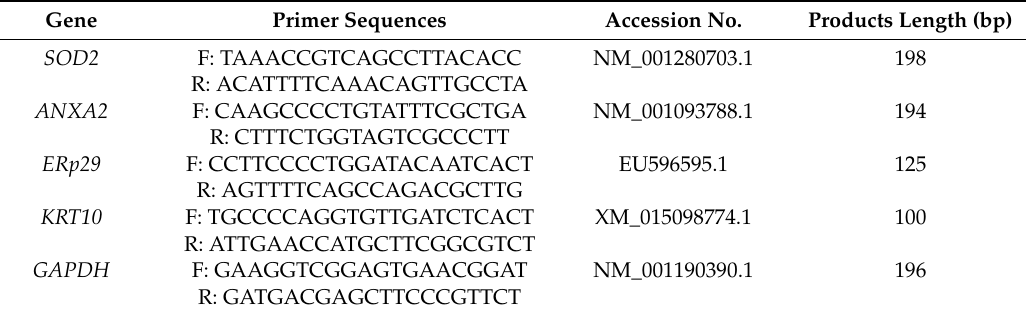
Table 1. Primers of qRT–PCR used in this